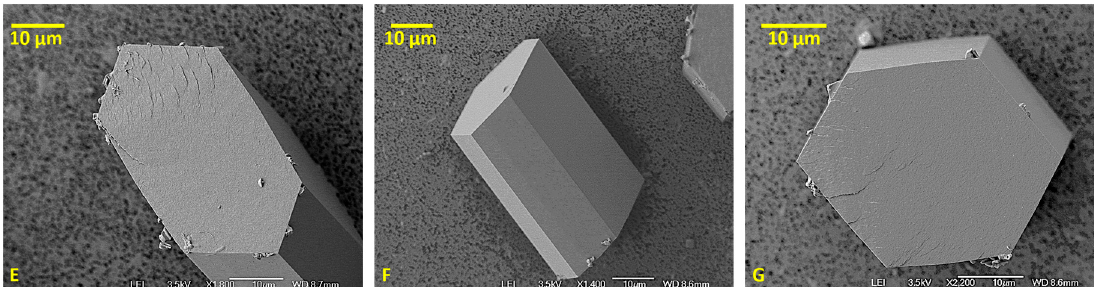
Figure 15. SEM images of individual gypsum crystals. While these crystals show different proportions between different surfaces (i.e., different morphology), they have all precipitated from the same brine (comprised of 85% wt. Dead Sea brine and 15% wt. seawater). Reprinted from Reiss et al. [158] with permission from the American Chemical